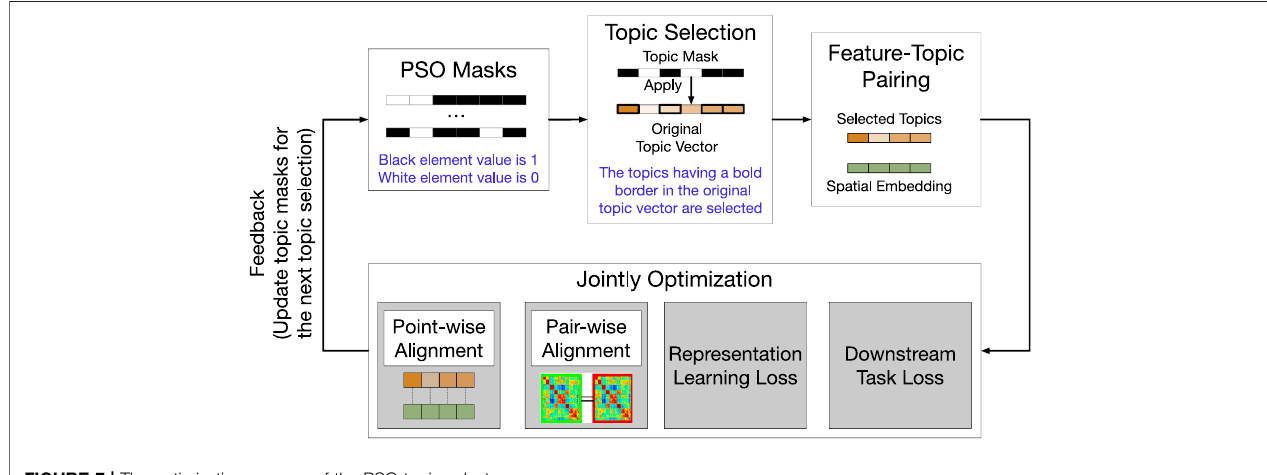
FIGURE 7 | The optimization process of the PSO topic selector.